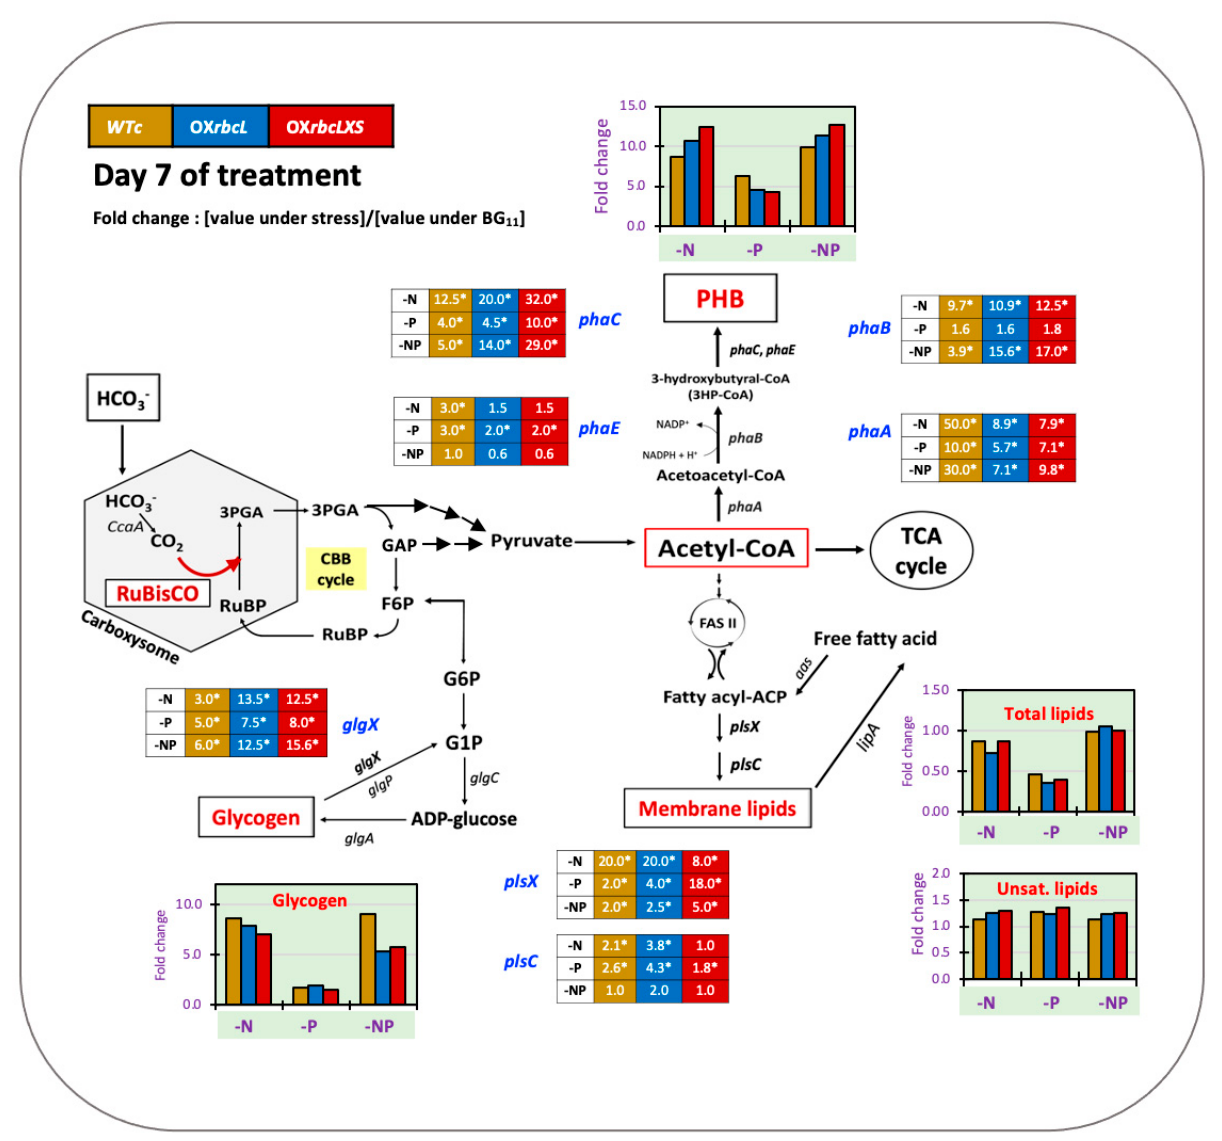
Figure 9. Summary of obtained results, including products and gene transcript levels from two overexpressing strains, including comparisons to Synechocystis sp. PCC6803 WTc after adapting cells in BG 11 , BG 11 -N, BG 11 -P, and BG 11 -NP at day 7 of treatment. In each box and bar graph, the number and bar represent the fold change of that value of each strain under stress condition divided by that value of that strain under normal BG 11 condition. The statistical difference in the data between those values of WT and the engineered strain is represented by an asterisk at * p < 0.05.